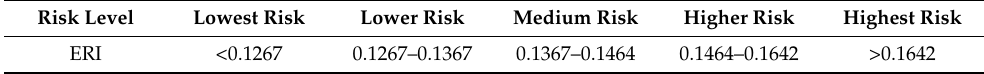
Table 4. Ecological risk